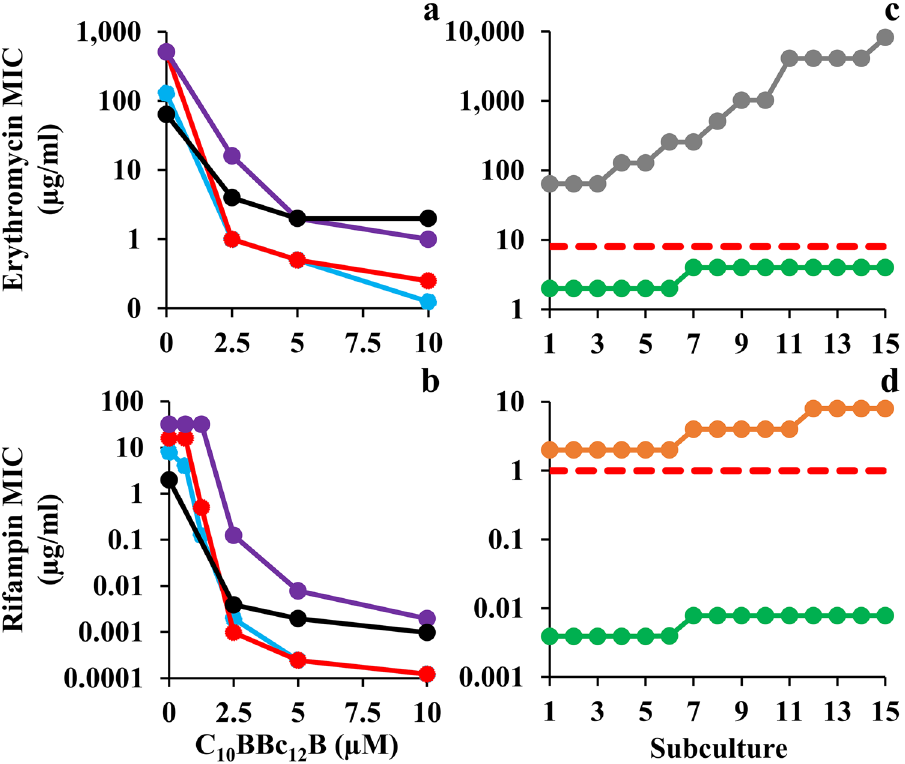
Figure 2. Sensitization of Gram-Negative ESKAPE Pathogens to Antibiotics. ( a , b ) Isobolograms generated for inhibitory combinations of C 10 BBc 12 B with erythromycin and rifampin, respectively. E. coli 25922, cyan; K. pneumoniae 1287, red; P. aeruginosa 27853, purple; A. baumannii 19606, black. ( c , d ) Antibiotic MIC evolution over 15 consecutive subcultures of A. baumannii 19606, as tested in duplicates, in absence versus in